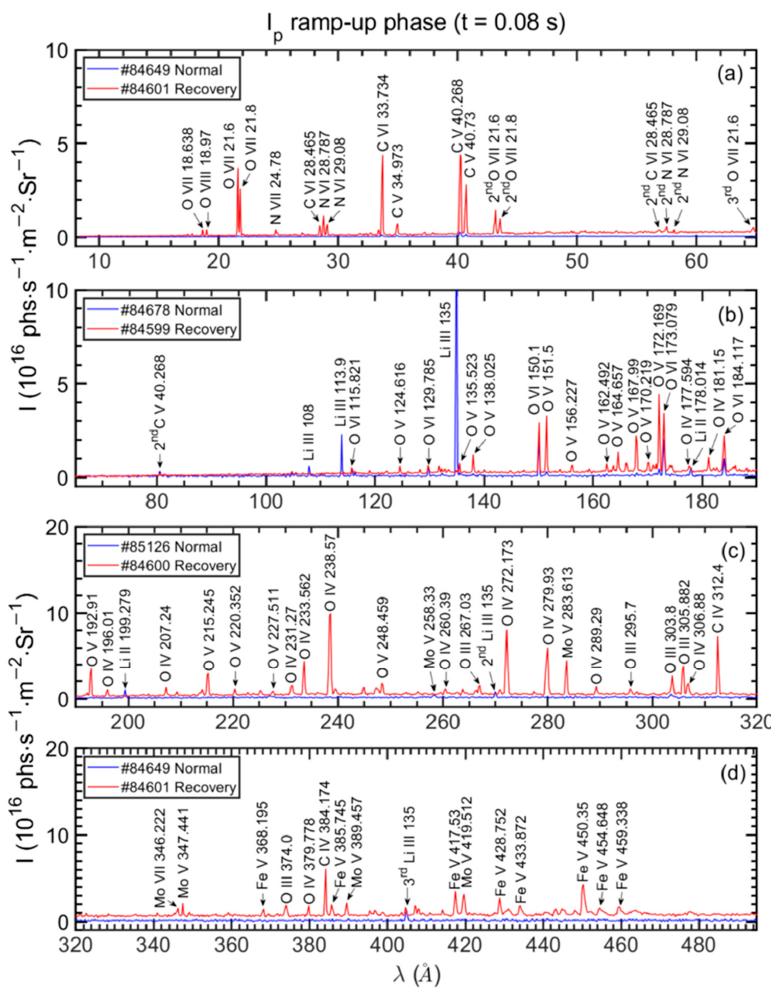
Figure 5. EUV spectra comparison during I p ramp-up phase (t = 0.08 s) of recovery (red lines) and normal (blue lines) discharges. ( a ) 8–65 Å, ( b ) 65–190 Å, ( c ) 190–320 Å, and ( d ) 320–495 Å.